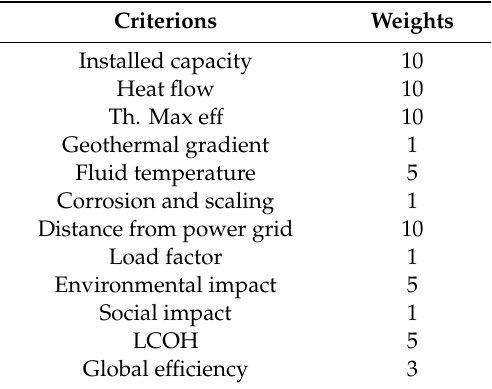
Table 4. District heating assigned